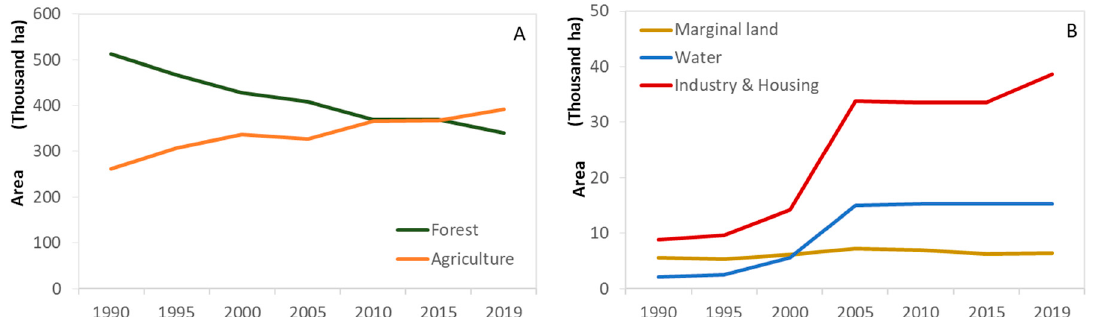
Figure 7. Land cover changes in Binh Thuan province derived from Landsat time series (1990–2019) (Appendix A). ( A ): forest and agriculture. ( B ): marginal land, water and industry and housing. Note: the scaling of the y -axis is not equivalent for the two plots.